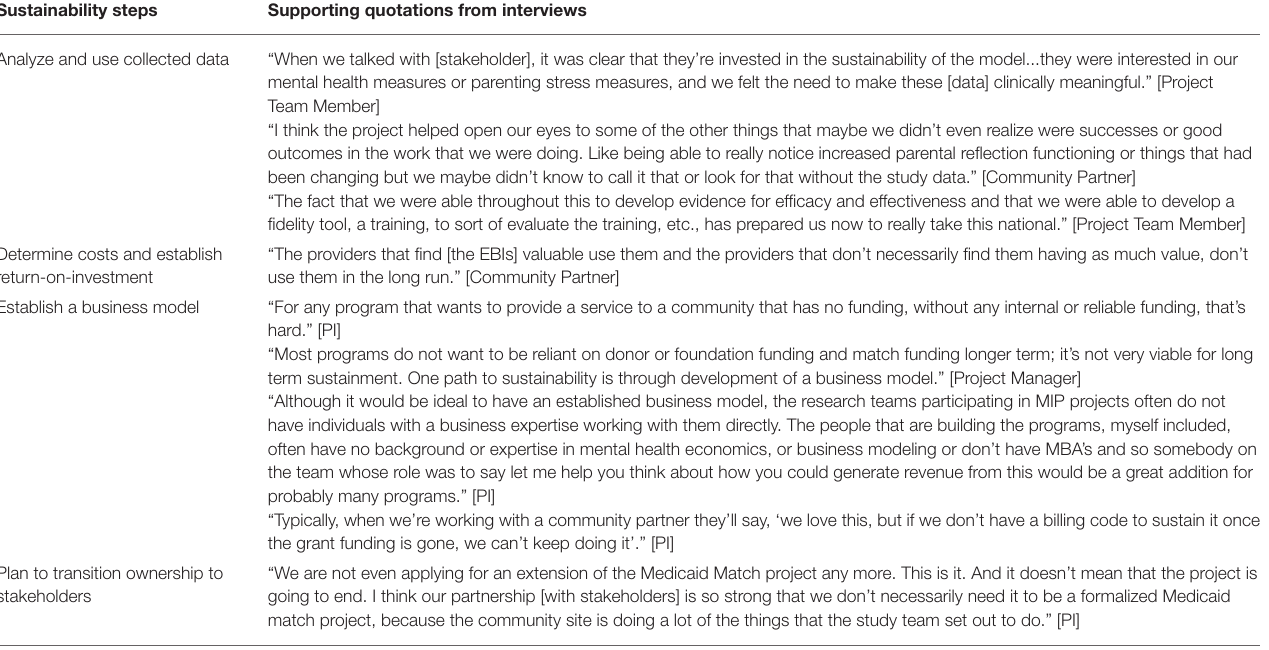
TABLE 6 | Sustainability illustrative quotes. Sustainability steps Supporting quotations from